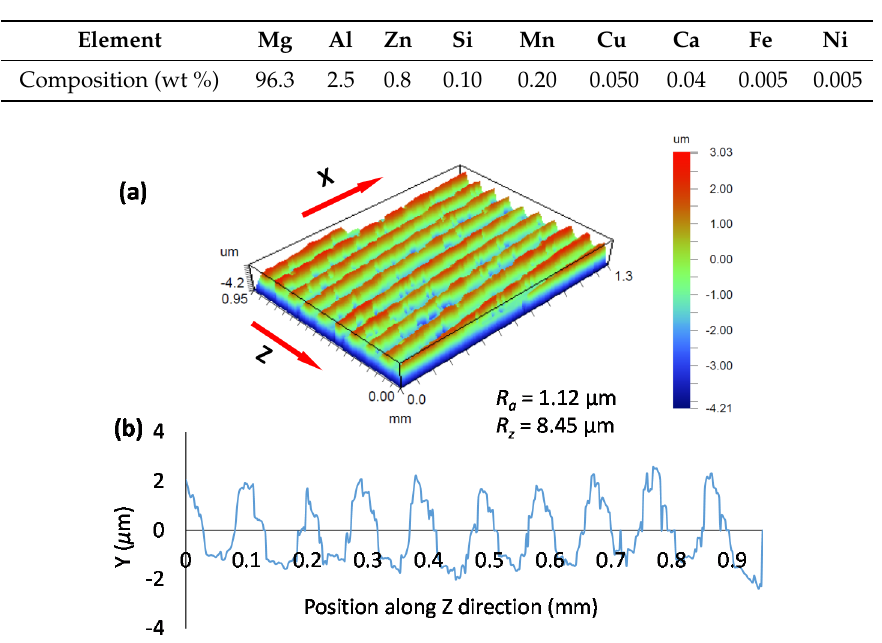
Figure 1. Milled surface topography before burnishing ( a ) 3D and ( b ) 2D profiles.